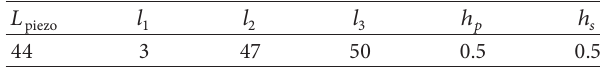
Table 2: Dimension parameters of the vibrator